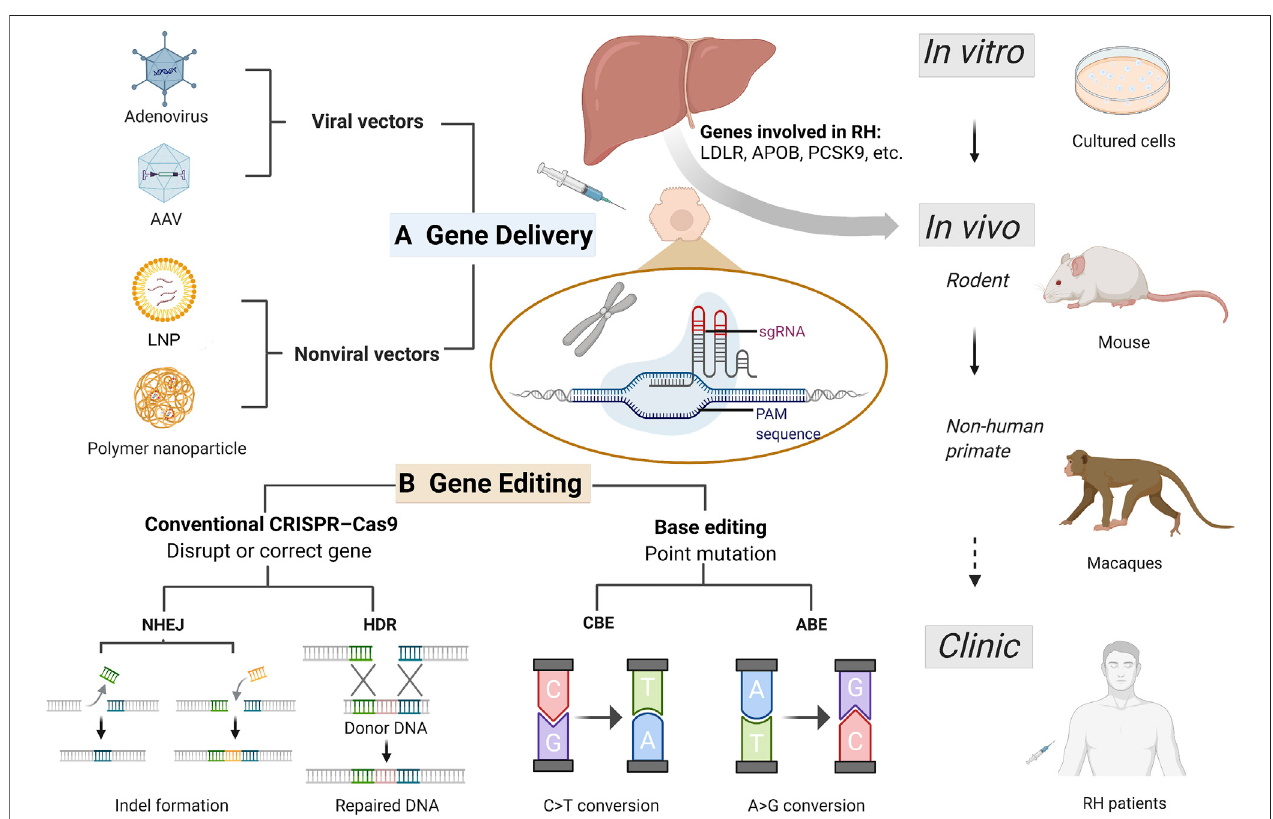
FIGURE 1 | Current CRISPR/Cas9 based gene therapy for refractory hypercholesterolemia. Refractory hypercholesterolemia (RH) including homozygous familial hypercholesterolemia and compound heterozygous familial hypercholesterolemia, associated with mutations in genes encoding LDLR, APOB, PCSK9, etc. Ef fi cient vectorsenabledeliveryofCRISPRprogenitorsandgeneticmaterials invitro and invivo ,andthedevelopmentofCRISPRtechnologyhasimproveditsef fi cacyandsafety in target gene editing. Gene therapy experiments have been successfully conducted in cells (including human induced pluripotent stem cell), mice and non-human primates,expectedtobeusedforclinicaltreatment inthefuture. (A) Common deliveryvectorsusedinRHgenetherapy.Adenovirusandadeno-associated virusarethe most frequently used viral vectors in RH gene therapy. Non-viral vectors including lipid nanoparticle and engineered polymer nanoparticles offer more options for gene delivery with greater capacity and less toxicity and immunogenicity. (B) Gene editing based on CRISPR/Cas9 system for treating RH. For RH-related genes, gene disruption and correction can be achieved using conventional CRISPR-Cas9 and base editing techniques. In conventional CRISPR-Cas9, NHEJ can induce indel mutation(insertionordeletion),achievingdisruptionofpro-atheroscleroticgenessuchasPCSK9andANGPTL3;andHDRcancorrectadisease-causingmutationfrom donor DNA. Base editing is a new generation of CRISPR technology that enables single-nucleotide changes without double-strand breaks for precise gene editing. CRISPR-Cas9, clustering regularly spaced short palindromic repeats (CRISPR) and CRISPR-associated protein; RH, refractory hypercholesterolemia; AAV, adeno- associated virus; LNP, lipid nanoparticle; PAM, protospacer-adjacent motif; sgRNA, single guide RNA; NHEJ, non-homologous end joining; HDR, homology-directed repair; CBE, cytosine base-editors; ABE, adenine base-editors.